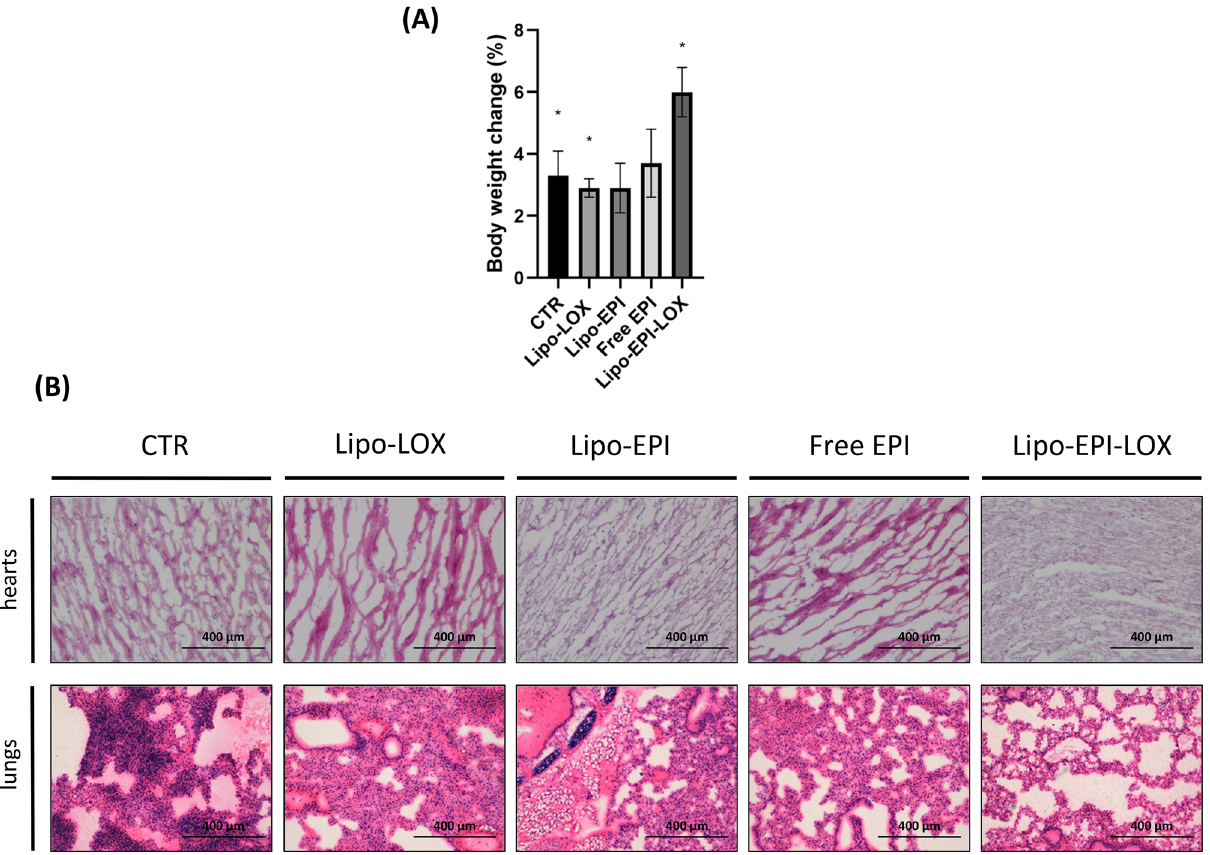
Figure 5. ( A ) body weight change percentage of mice at the end of the study. ( B ) Representative example of H&E stained sections of explanted hearts 55 days post treatment. Control: normal cardiac tissue. Lipo-LOX: no increase of inflammatory infiltrate. Lipo-EPI: minimal focal increase of inflammatory infiltrate (granulocytes and lymphocytes), artifacts. Free EPI: increased cellularity due to possible inflammatory infiltrate. Lipo-EPI- LOX : no significant increment of lymphoid infiltrate, artifacts. Scale bar is 400 µm. Representative example of H&E stained sections of explanted lungs 55 days post treatment. Control: phlogosis 70%. Lipo-LOX: phlogosis 30%. Lipo-EPI: phlogosis 15%. Free EPI: phlogosis 15%. Lipo-EPI-LOX : phlogosis 5%. Scale bar is 400 collagen stiffness and linearization was observed with LIPO-LOX and LIPO-EPI-LOX (Fig. 4C). Reducing LOX- mediated collagen crosslinking decreased focal adhesions and PI3K activity, hampered malignancy, and lowered